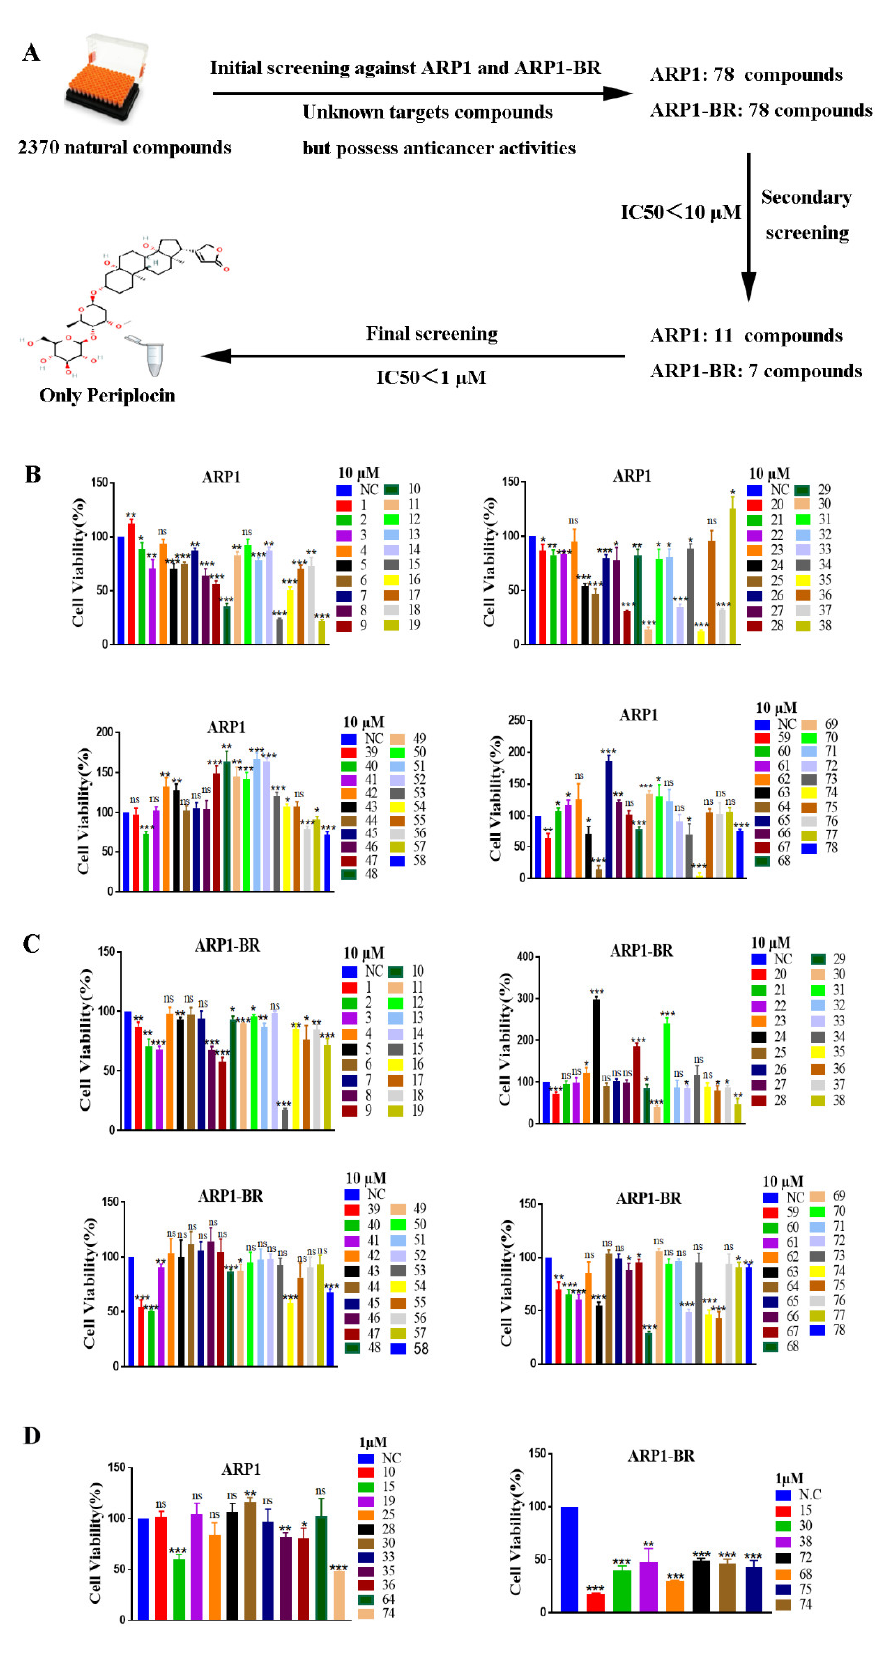
Figure 1. Periplocin is an effective anti-MM natural compound. ( A ) Schematic diagram of PP identification as the most significant anti-MM agent among 2370 anticancer compounds against MM wild type ARP1 and MM BTZ-resistant type ARP1-BR cell lines. ( B ) Effect of 78 drugs on cell via- bility of ARP1 through CCK-8 assay at a concentration of 10 μM, 11 drugs had IC50 < 10 μM for ARP1 (the number in figures represents a drug; No. 74 represents PP). ( C ) Effect of 78 drugs on cell viability of ARP1-BR through CCK-8 assay at a concentration of 10 μM, 7 drugs had IC50 < 10 μM